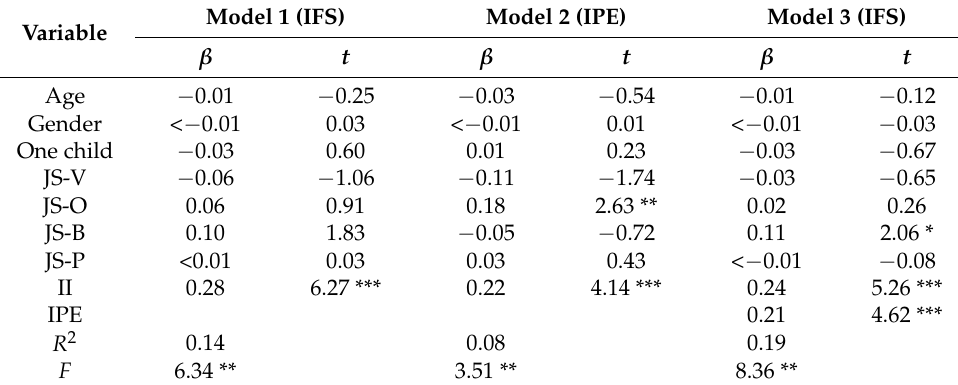
Table 3. Results of the mediation